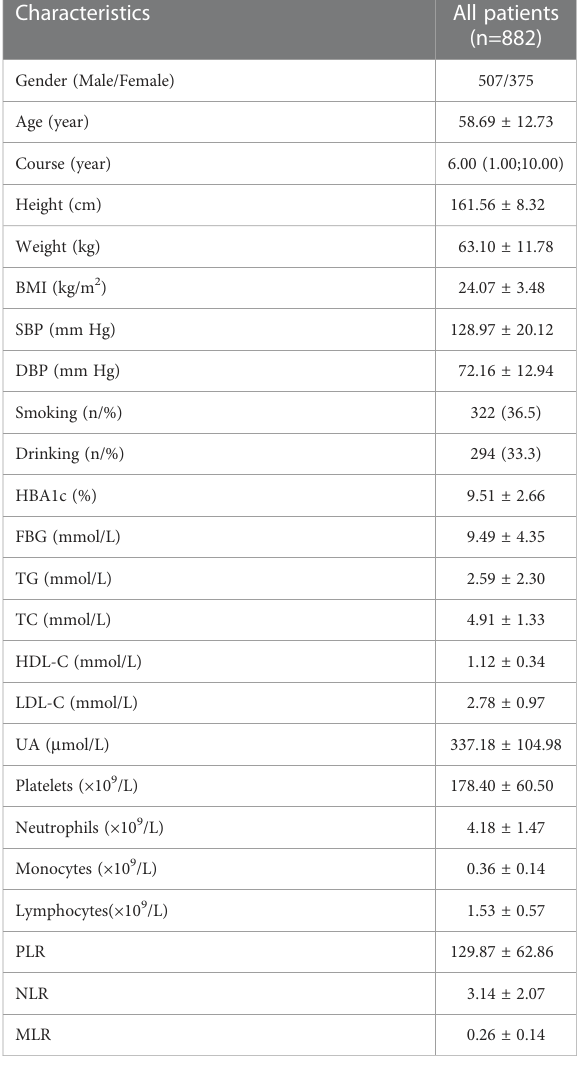
TABLE 1 Patients ’ pro fi les.